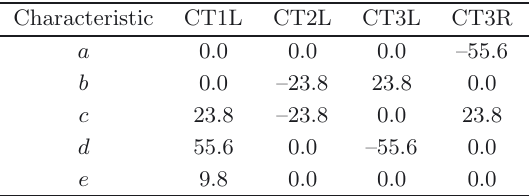
Table 10. Weighted matrix A (cid:2) .